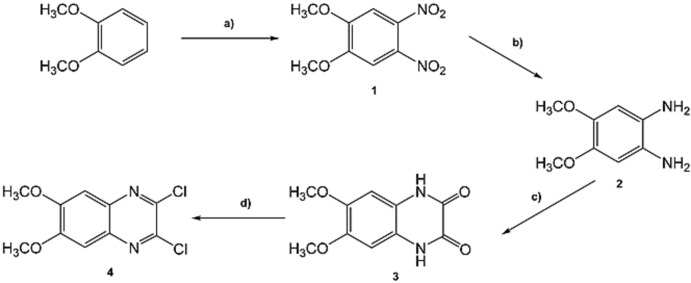
Synthesis of 4: a) HNO3 65%, 373 K, 8 h, 80%; b) Pd/C 10%, H2 3 bar, EtOH, RT, 24 h, 100%; c) Oxalic acid, HCl 4 N, 373 K, 16 h, 77%; d) POCl3, di­chloro­ethane, 363 K, 16 h, 80%.